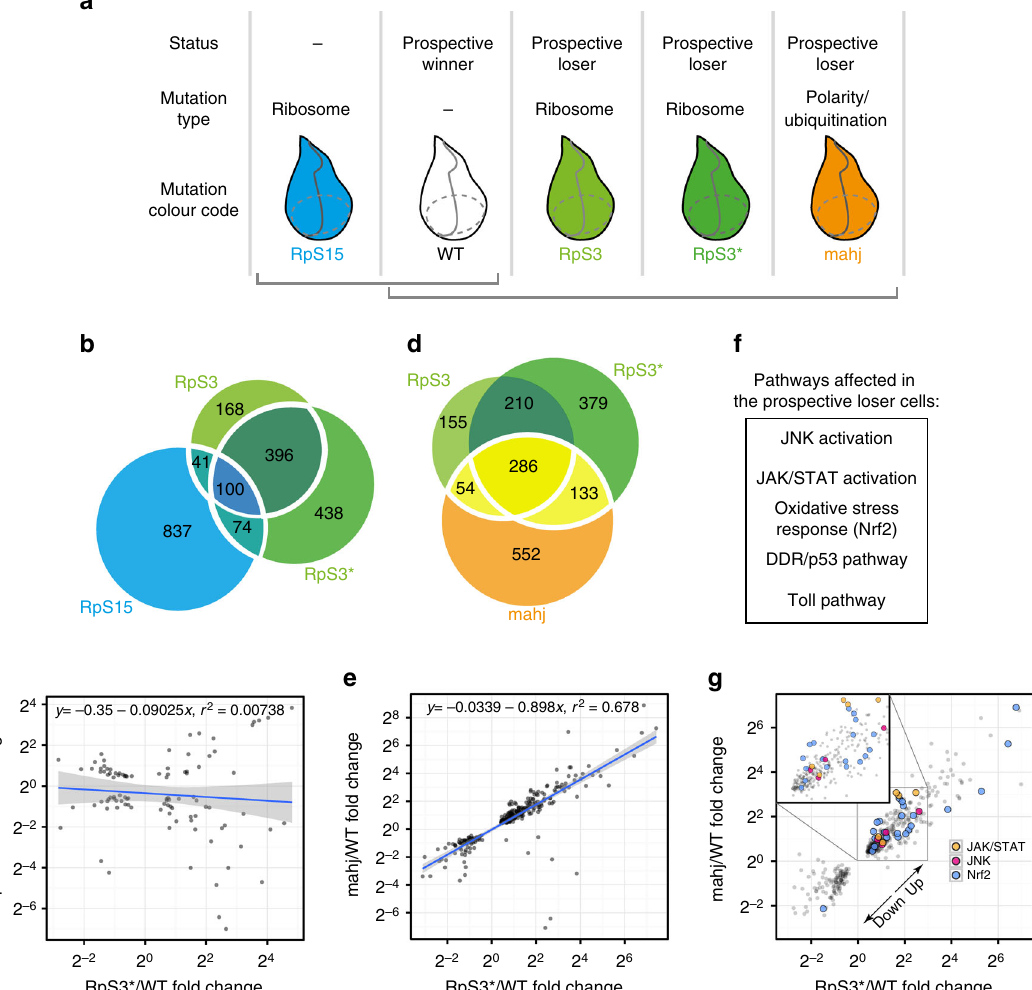
Fig. 1 Transcriptional pro fi ling identi fi es a molecular signature common to prospective loser cells. a Schematic representation of the genotypes used for transcriptional pro fi ling and their corresponding prospective loser/winner status. b Venn diagram showing overlap of genes differentially expressed in RpS3 , RpS3 * and RpS15 compared to wild type (WT). c Linear regression of fold changes of differentially expressed genes in WT vs. RpS3 * and WT vs. RpS15 , shaded area indicates 95% con fi dence interval for the fi t. d Venn diagram showing overlap of genes differentially expressed in RpS3 , RpS3* and mahj compared to WT. e Linear regression of fold changes of differentially expressed genes in WT vs. RpS3* and WT vs. mahj , shaded area indicates 95% con fi dence interval for the fi t. f Pathways activated in prospective loser cells. g Data set of differentially expressed genes as in e , where genes